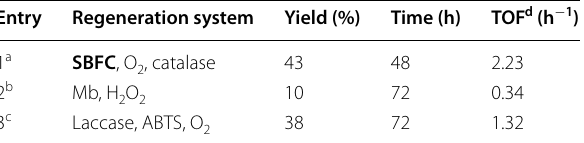
Table 3 HLADH-catalyzed oxidative lactonization reaction mediated by different regeneration systems